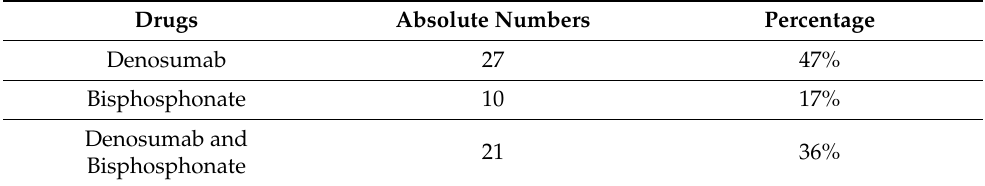
Table 4. Type of antiresorptive medication ( n = 58).